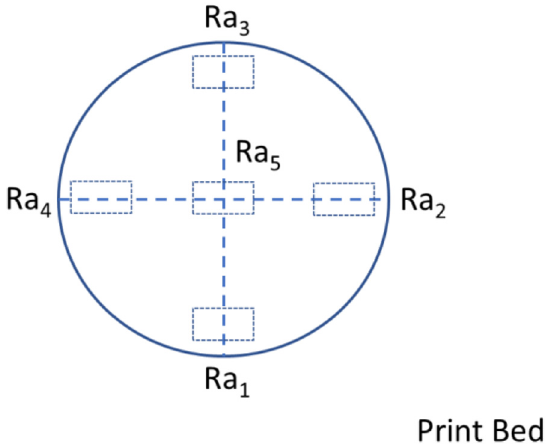
Fig. 3. Workpiece and measured position (top view of print bed).